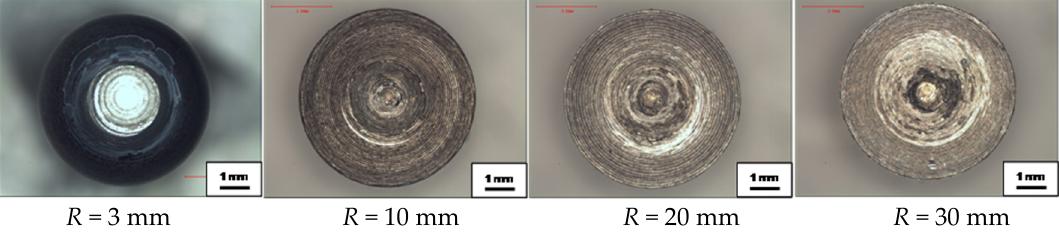
Figure 6. Over top view of tool tip after FSB processing.